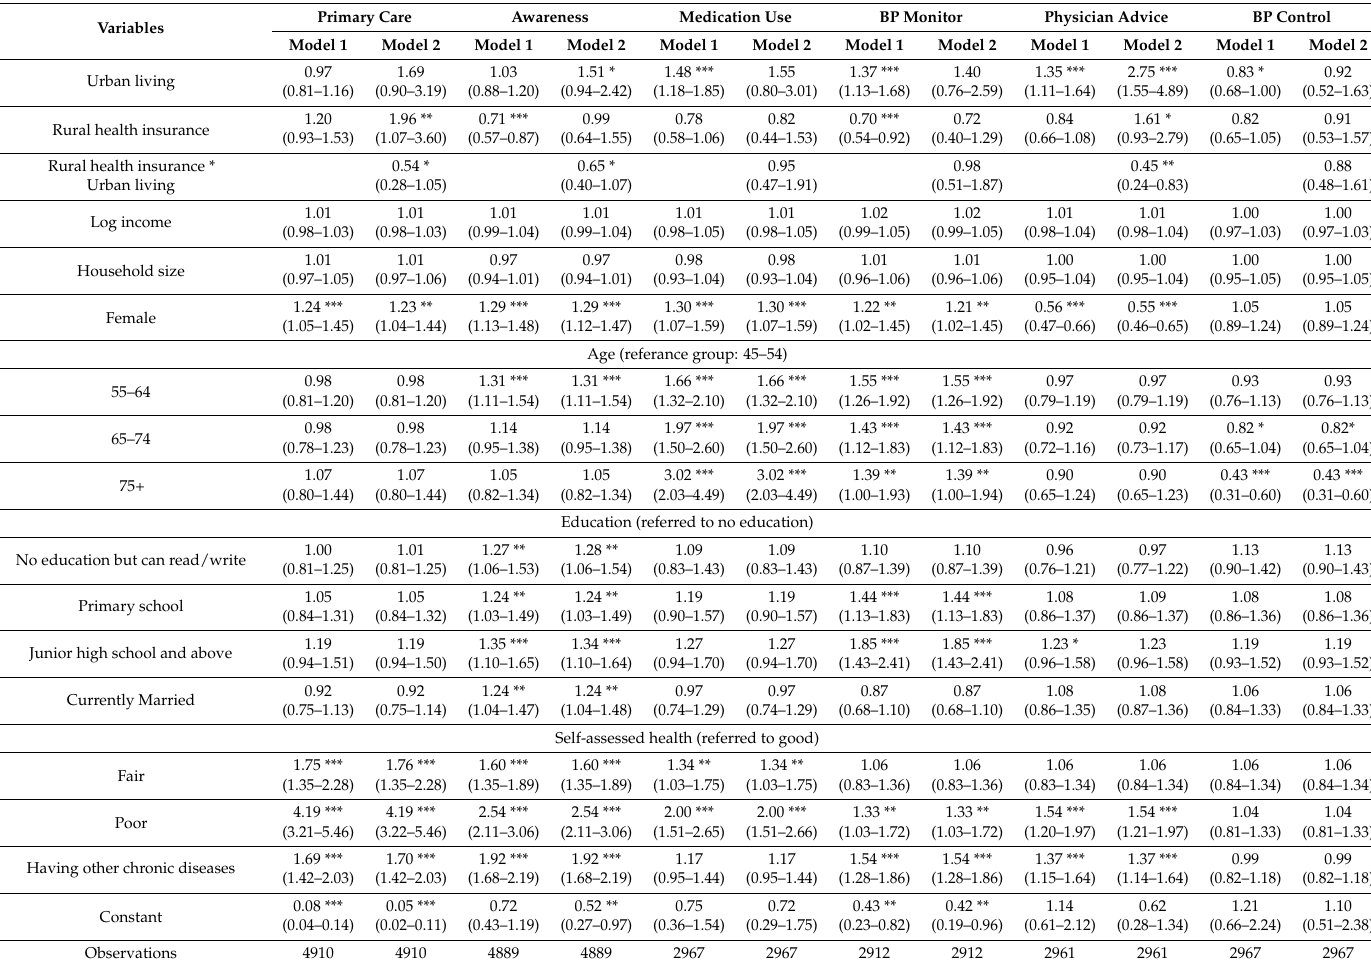
Table 3. Adjusted odds ratios (95% Confidence Interval (CI)) for hypertension management by logistic